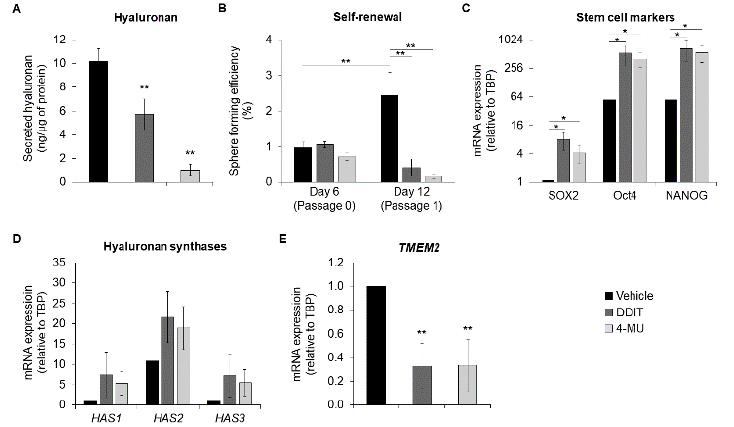
Figure 9. DDIT inhibits self-renewal of breast cancer stem cells. ( A ) Hyaluronan secreted by Hs578T mammospheres after 6 days of treatment with vehicle (0.04% DMSO), DDIT (80 µ M) or 4-MU (1 mM). ( B ) Breast cancer stemness was assessed by quantification of Hs578T sphere forming efficiency after one passage (6 days per passage, totally 12 days), in the presence of vehicle, DDIT or 4-MU. ( C ) mRNA expression of stem cell factors ( SOX2 , OCT4 and NANOG ). ( D ) hyaluronan synthases ( HAS1 , HAS2 and HAS3 ) and ( E ) TMEM2 , were determined by RT-qPCR in Hs578T mammospheres grown for 6 days in the presence of vehicle, DDIT or 4-MU. Statistical significance is depicted as asterisks (*, p < 0.05; **, p < 0.01).